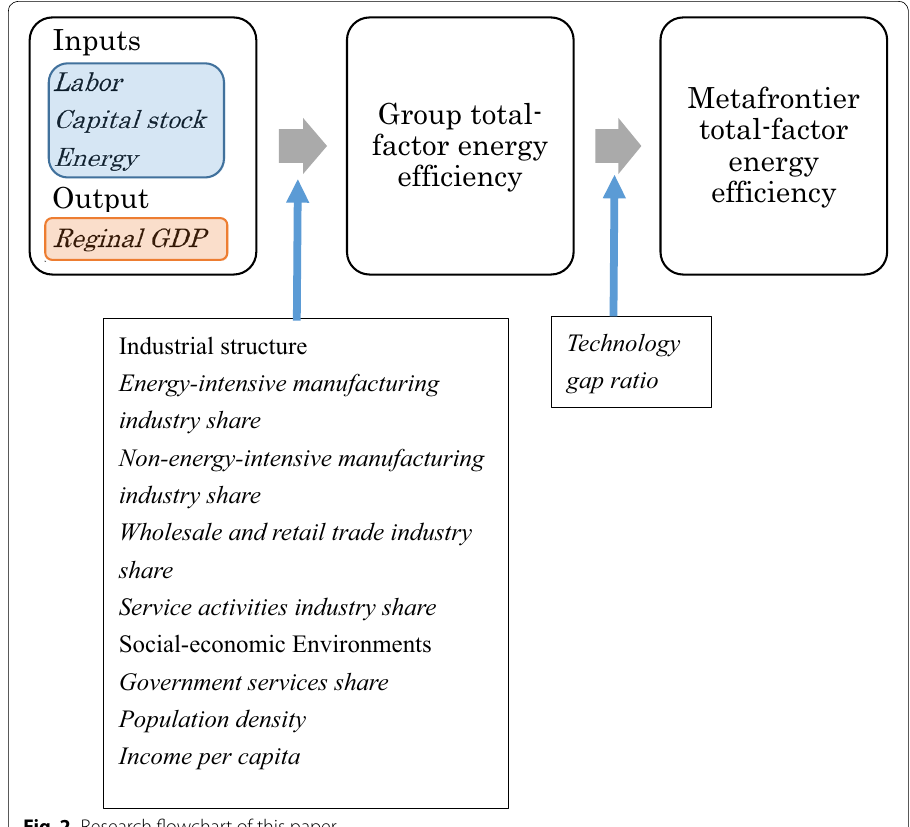
Fig. 2 Research flowchart of this